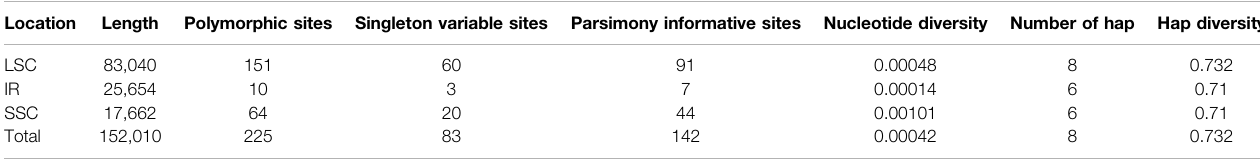
TABLE 2 | Haplotype diversity and mutation of 22 L. cardiaca accessions. Location